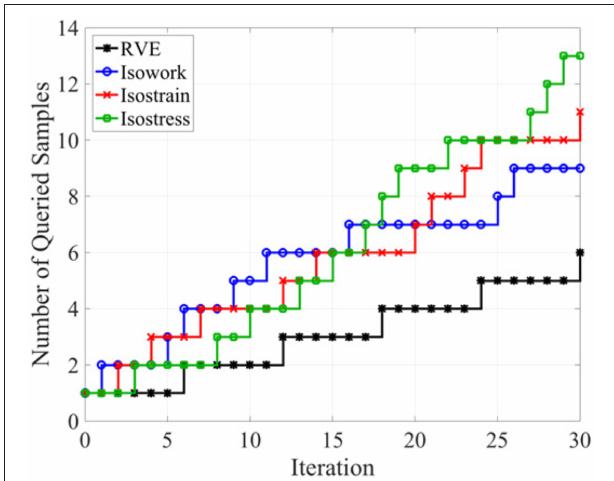
FIGURE 10 | Number of samples queried from the true model (RVE) and the information sources in each iteration. Image sourced from Ghoreishi et al. (2018); use permitted under the Creative Commons Attribution License